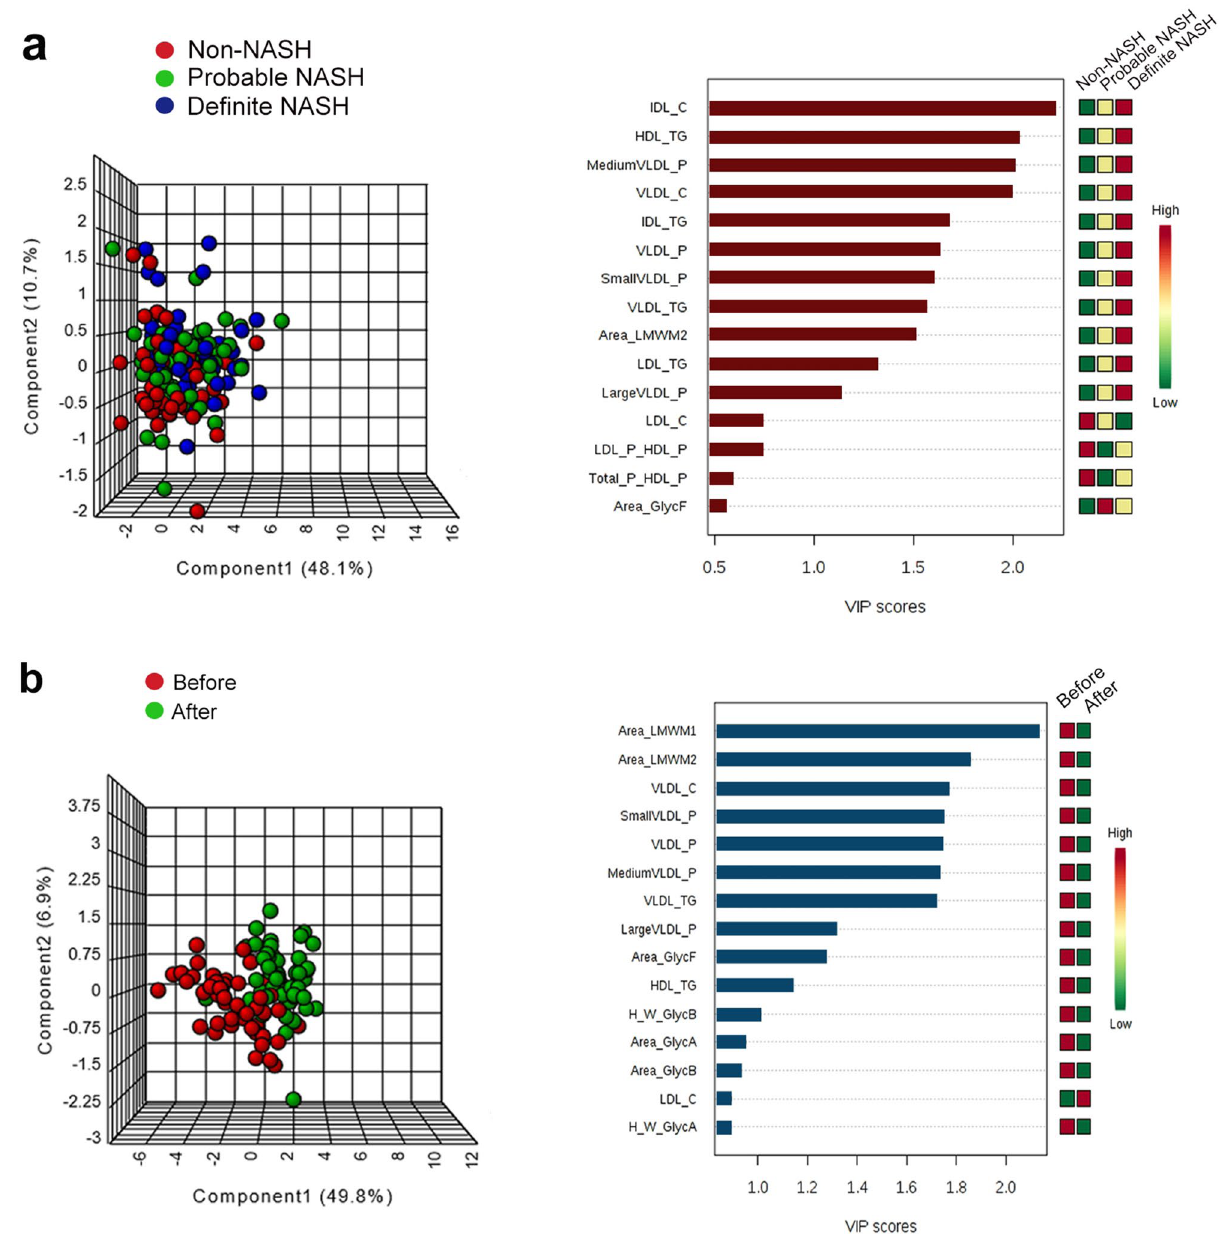
Figure 3. Score plots of the partial least square discriminant analysis (PLS-DA) and variable importance in projection (VIP) score analysis of measured lipoproteins and glycoproteins in patients with morbid obesity (n = 154), segregated according to the severity of hepatic alterations ( a ) or pre and post- laparoscopic sleeve gastrectomy ( b ). In the PLS-DA plots, the X and Y the axes represent combinations of the different variables analyzed so as to achieve a maximum separation between the groups. The VIP score is a measure of a variable’s importance in the PLS-DA model. It summarizes the contribution a variable makes to the model. The VIP score of a variable is calculated as a weighted sum of the squared correlations between the PLS-DA components and the original variable. The weights correspond to the percentage variation explained by the PLS-DA component in the model. The number of terms in the sum depends on the number of PLS-DA components found to be significant in distinguishing the classes. HDL high-density lipoproteins; IDL intermediate-density lipoproteins; LDL low-density lipoprotein; LSG laparoscopic sleeve gastrectomy; P particle concentration; VLDL very-low- density lipoproteins; Z particle